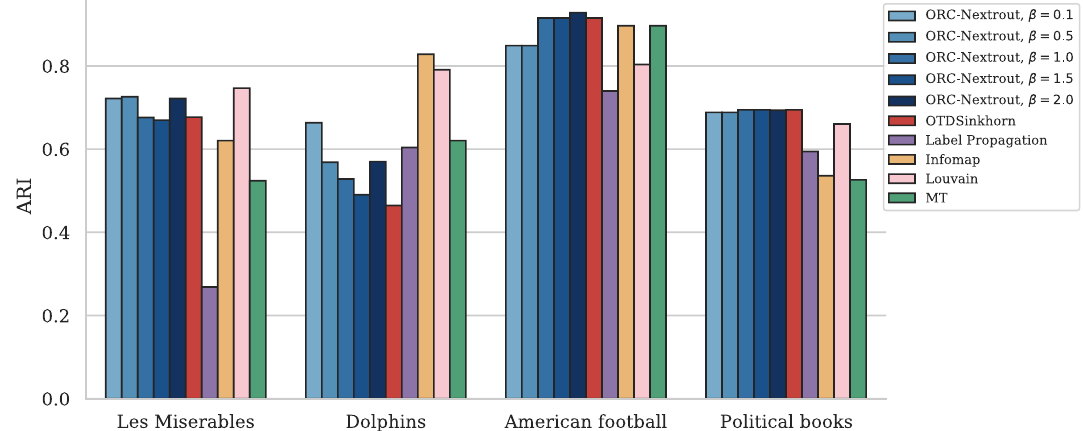
Figure 5. Results on real data. Performance in terms of recovering communities using metadata information is calculated in terms of the ARI score. ORC-Nextrout shows competing results against all methods with different optimal β across datasets.